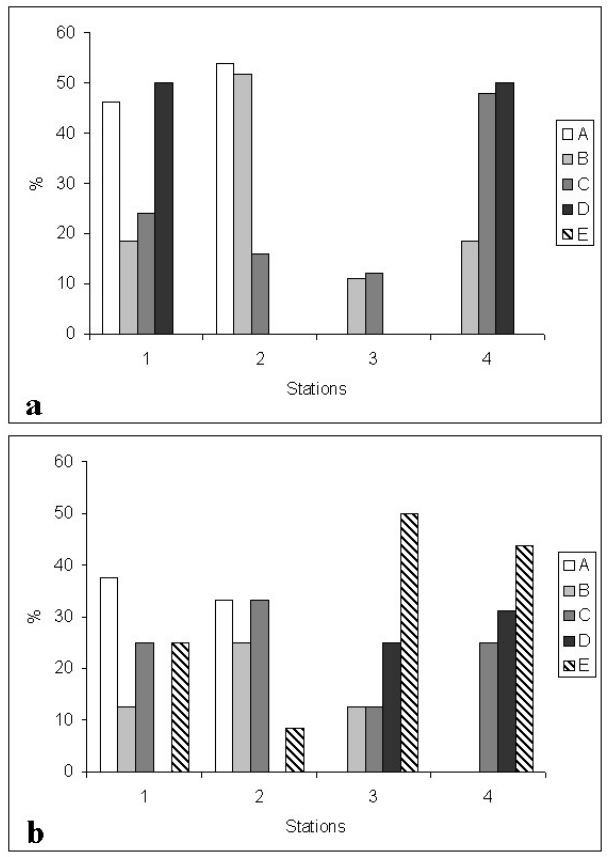
Fig. 7 . Bay whiff oocytes at different developmental stages: a)chromatin-nucleolar (CN), perinucleolar (PN), yolk vesicles and mature stages (M), H-E, 40 X; b) yolk vesicles and secondary yolk stage, and α and β atresia, H-E, 40 X; c) primary yolk stage and early β atresia, H-E, 40 X; d) high numbers of α and β atresia, H-E, 10 X ; e) and f) post-ovulatory follicles (POF), H-E, 40 X.